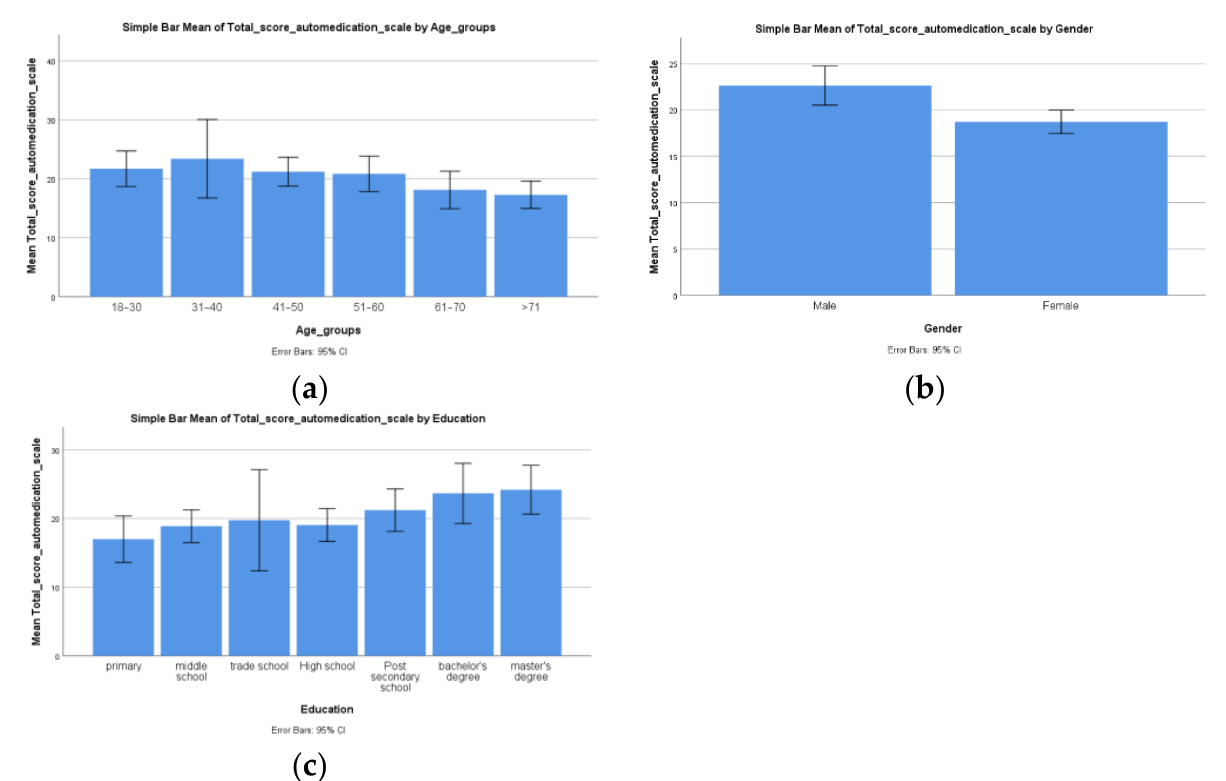
Figure 1. Socio-demographic aspects: Differences regarding the total score of self-medication scale for ( a ) every age group, ( b ) biological gender, and ( c ) every education group.